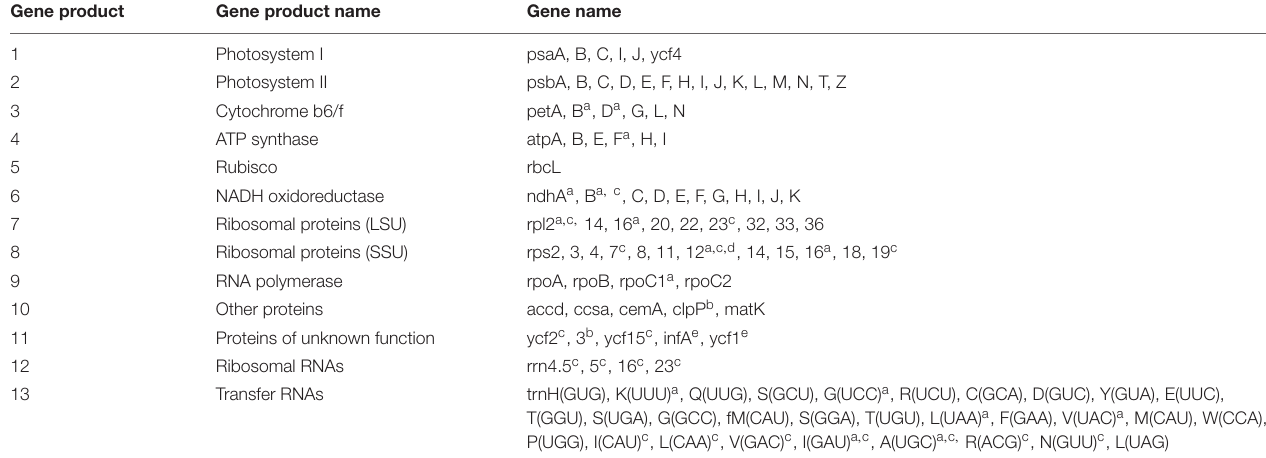
TABLE 1 | Genes in the jujube chloroplast genome.